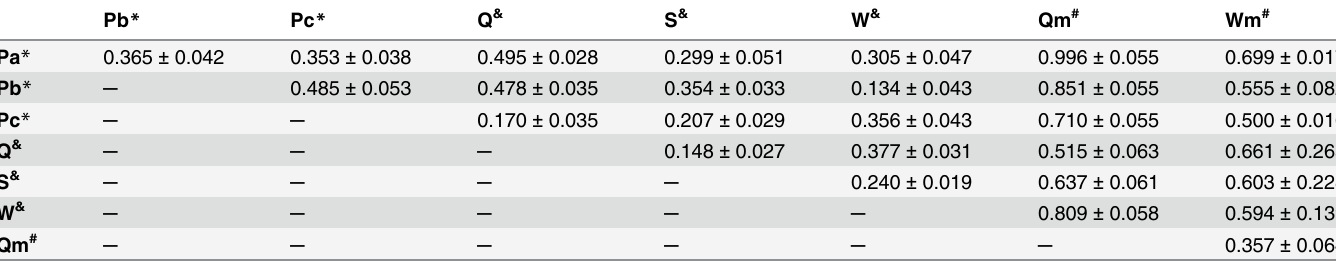
Table 1. Euclidean distances between sounds emitted by parasite and